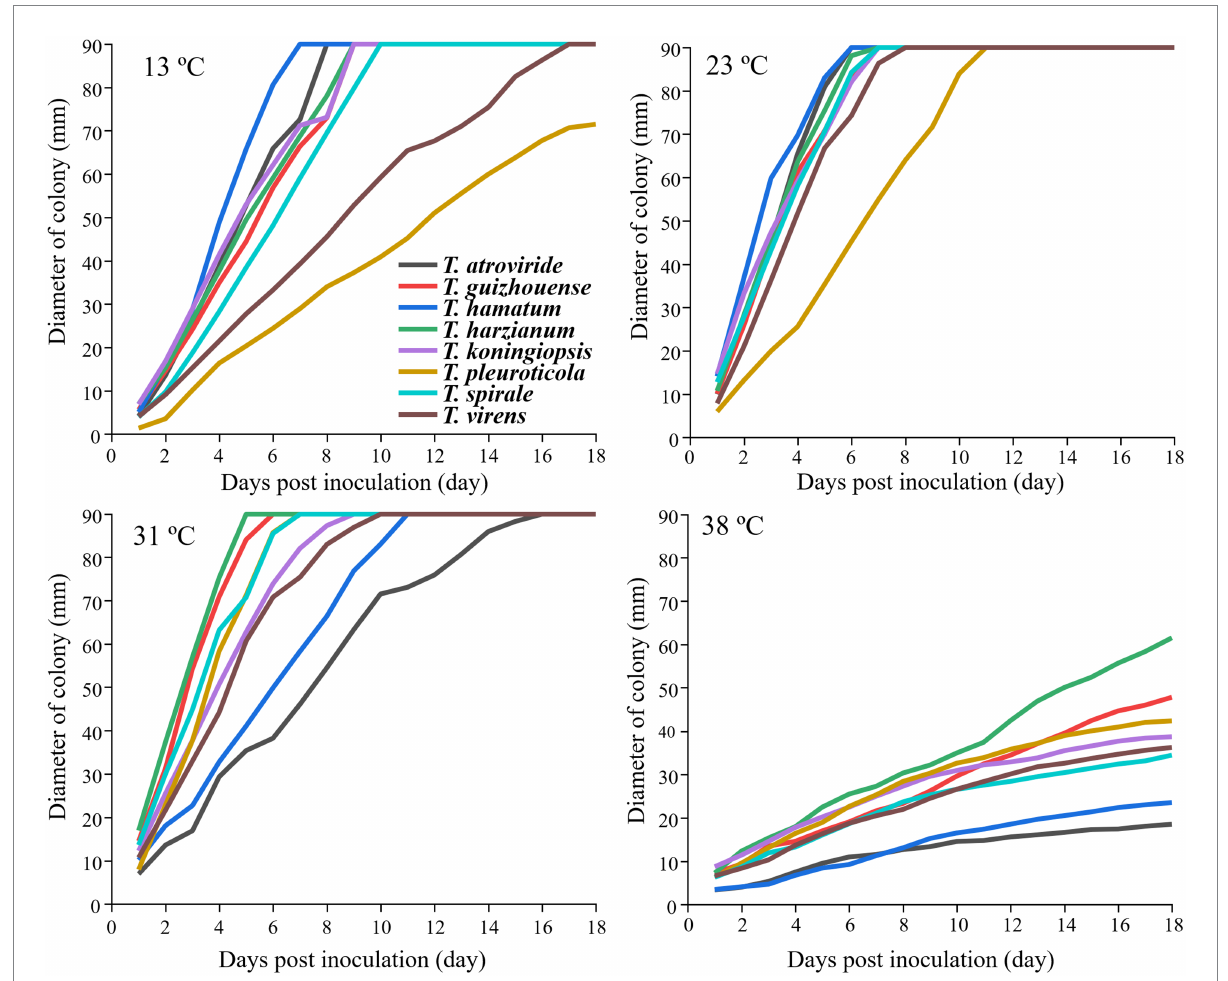
FIGURE 4 Effects of different temperatures on the mycelial growth of different Trichoderma strains on the PDA plates. Data represent the mean of two independent replicates with three plates